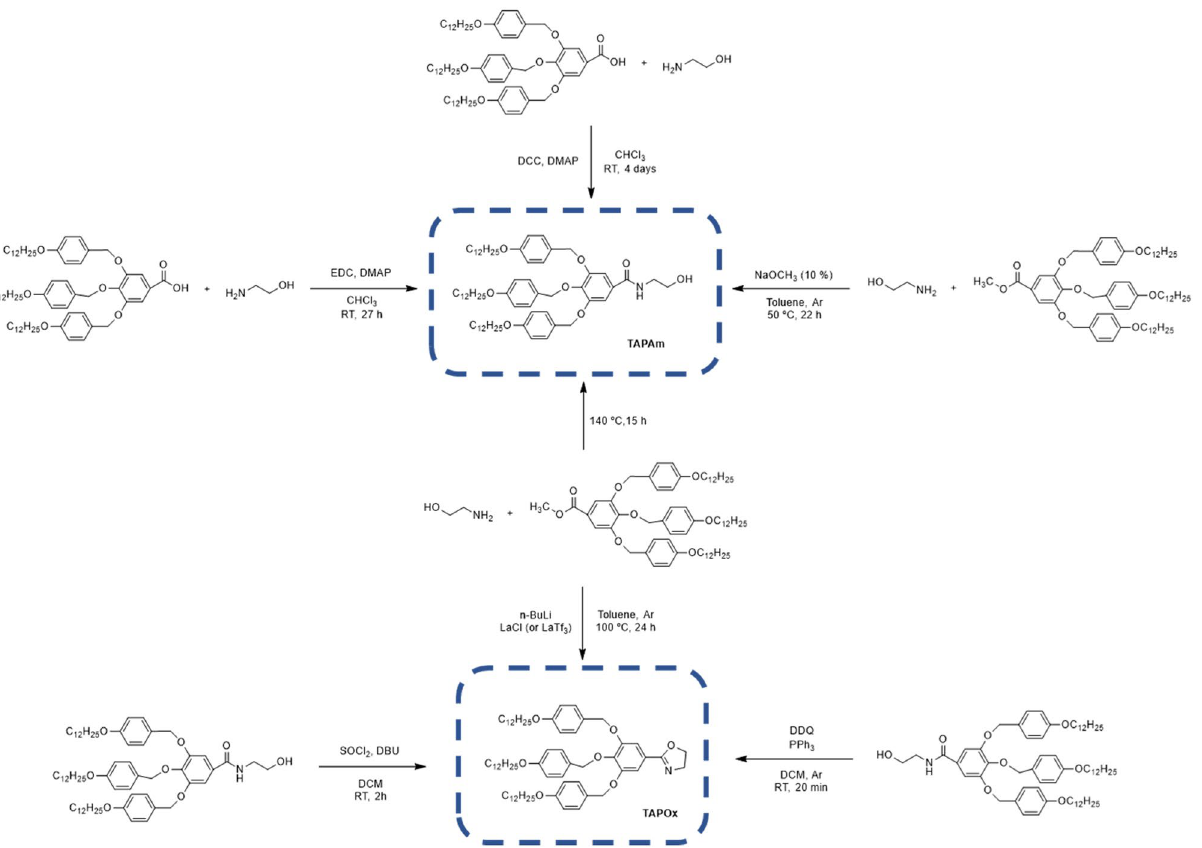
Figure 8. General scheme of the synthetic routes addressed in the synthesis of dendronized TAPOx